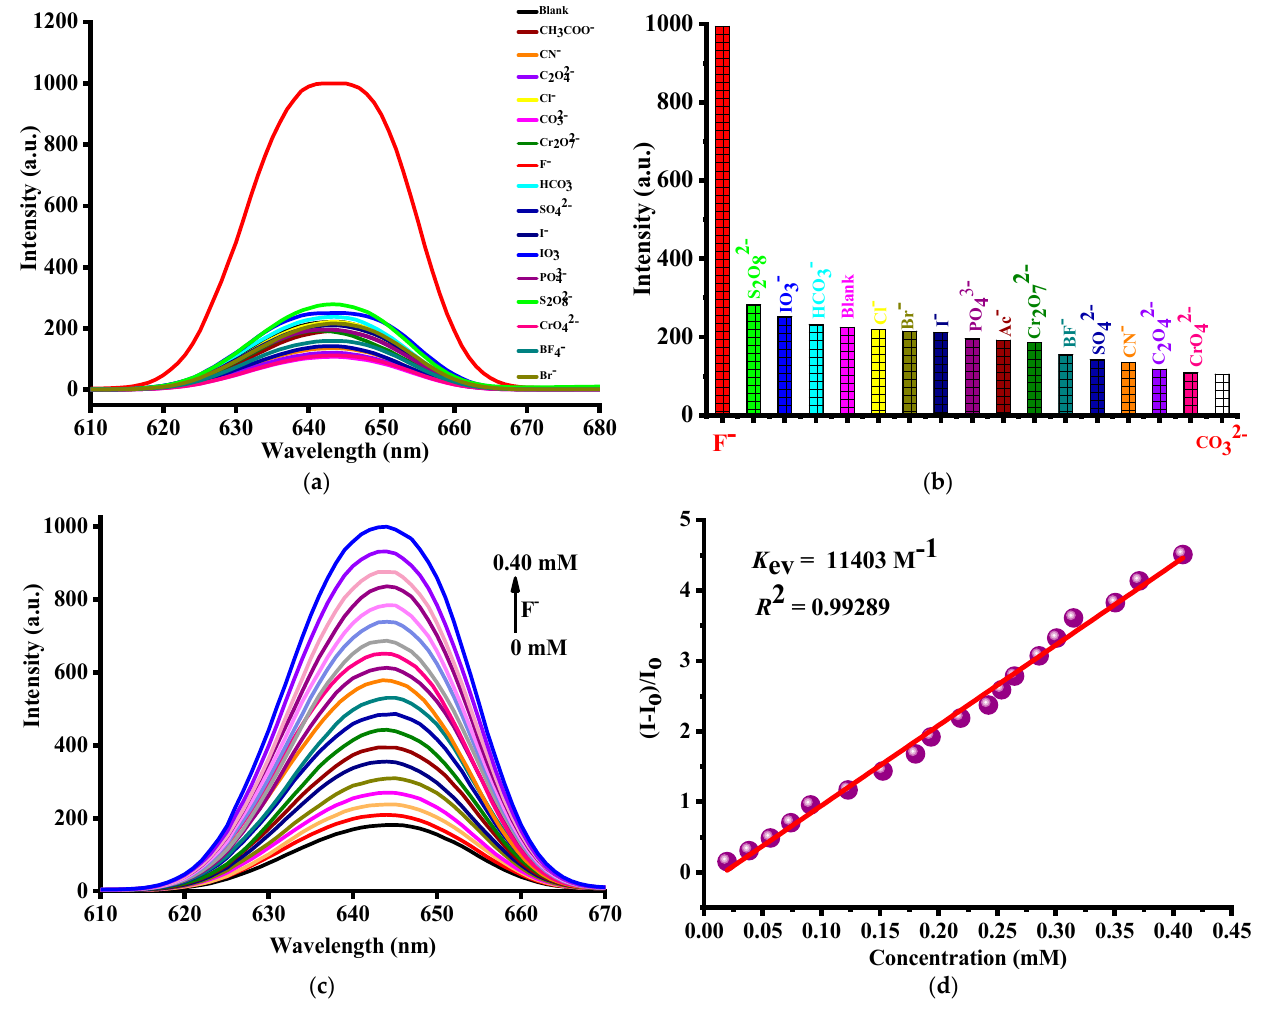
Figure 10. ( a ) Photoluminescence spectra of 1 in water and aqueous solutions containing different anions (1 × 10 − 3 M) when excited at 358 nm; ( b ) The photoluminescence intensities of 1 in aqueous solutions with various anions (1 × 10 − 3 M) when excited at 358 nm; ( c ) The emission spectra for 1 in aqueous solution of different F − concentrations; ( d ) The linear relationships for 1 in aqueous solution of different F − concentrations.